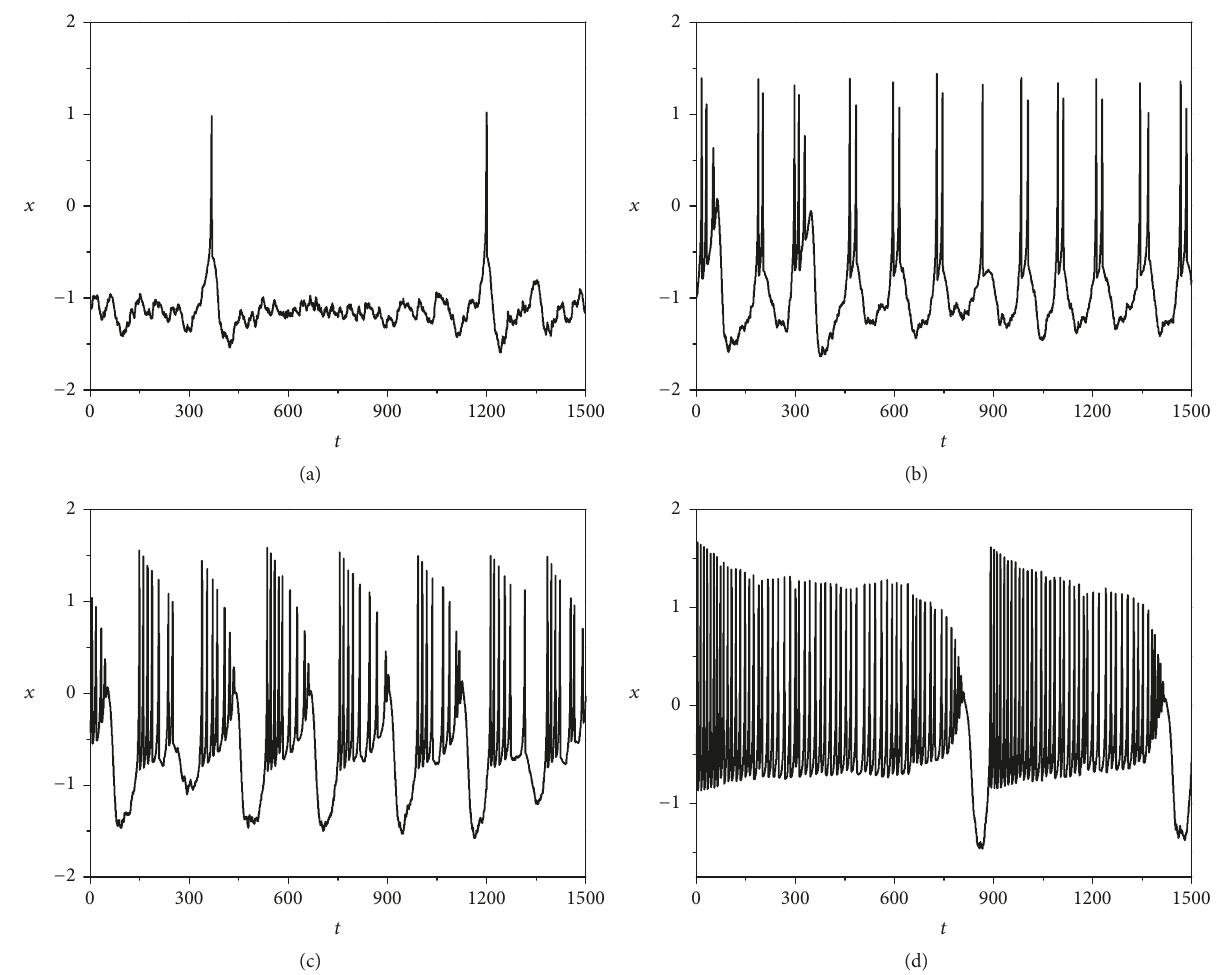
Figure 6: Sampled time series of membrane potential under different external direct current 𝐼 ext . 𝐷 = 0.2 . (a) 𝐼 ext = 1.5 . (b) 𝐼 ext = 2.3 . (c) 𝐼 = 3.5 . (d) 𝐼 = 4.5 ext ext